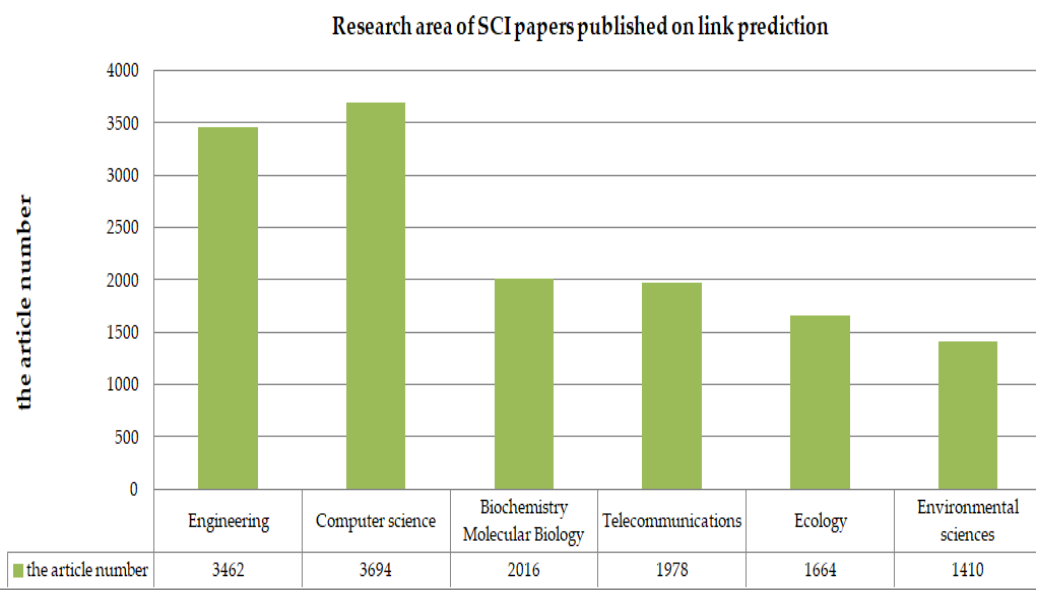
Figure 1. Research area of SCI papers published on link prediction.